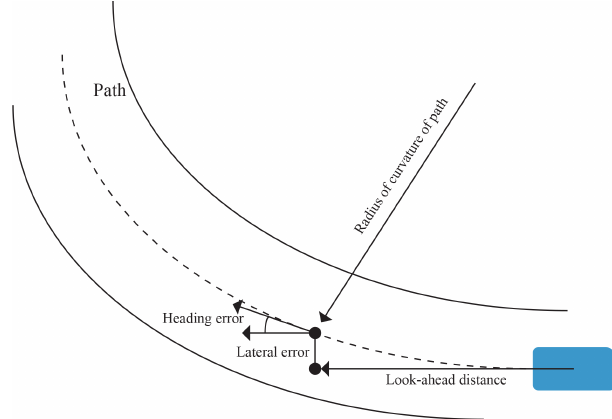
Figure 6. Path-following